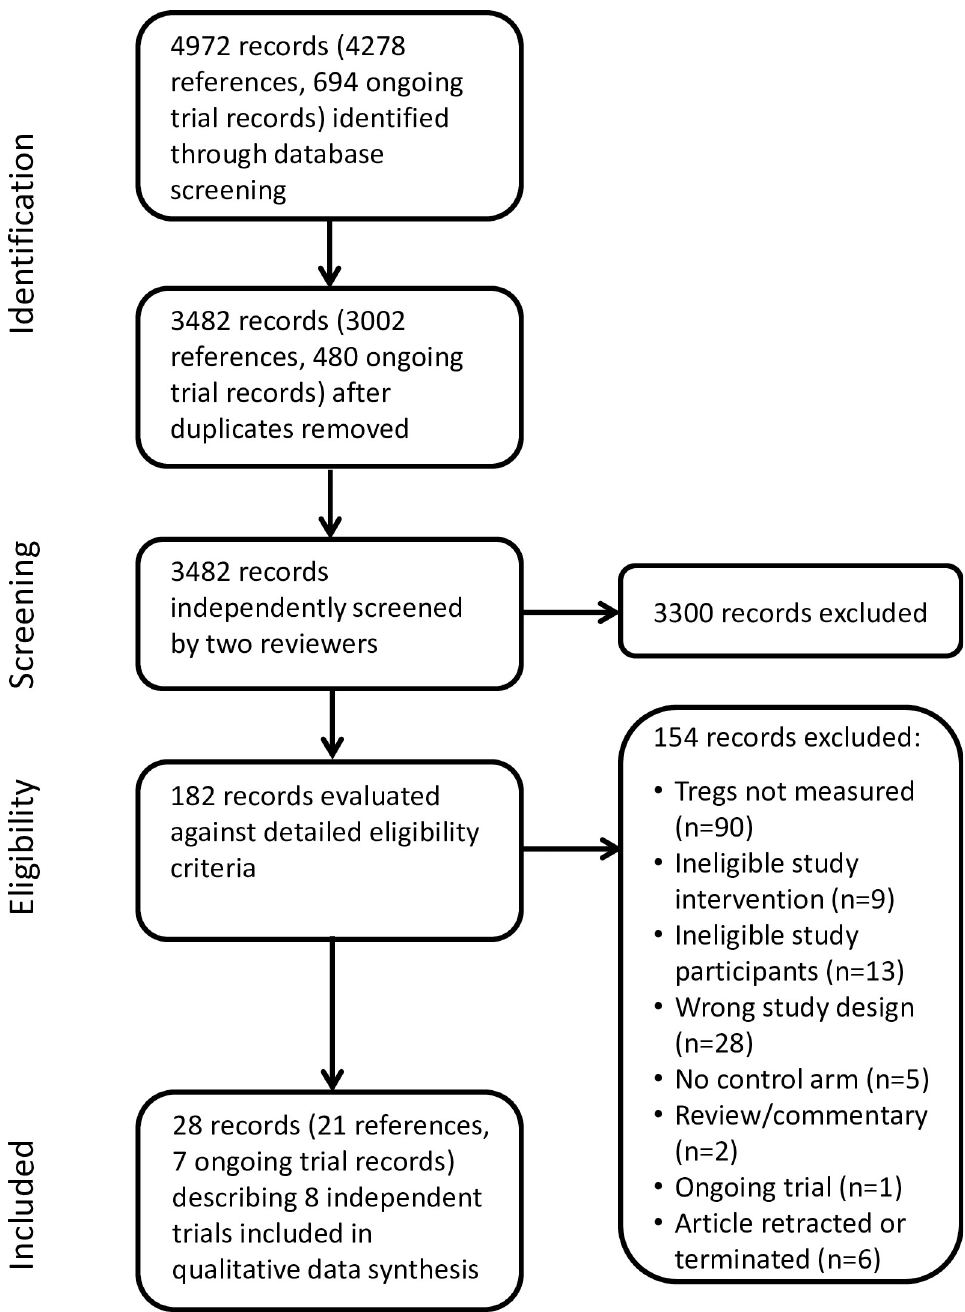
Fig 1. Study flow diagram showing the selection of eligible